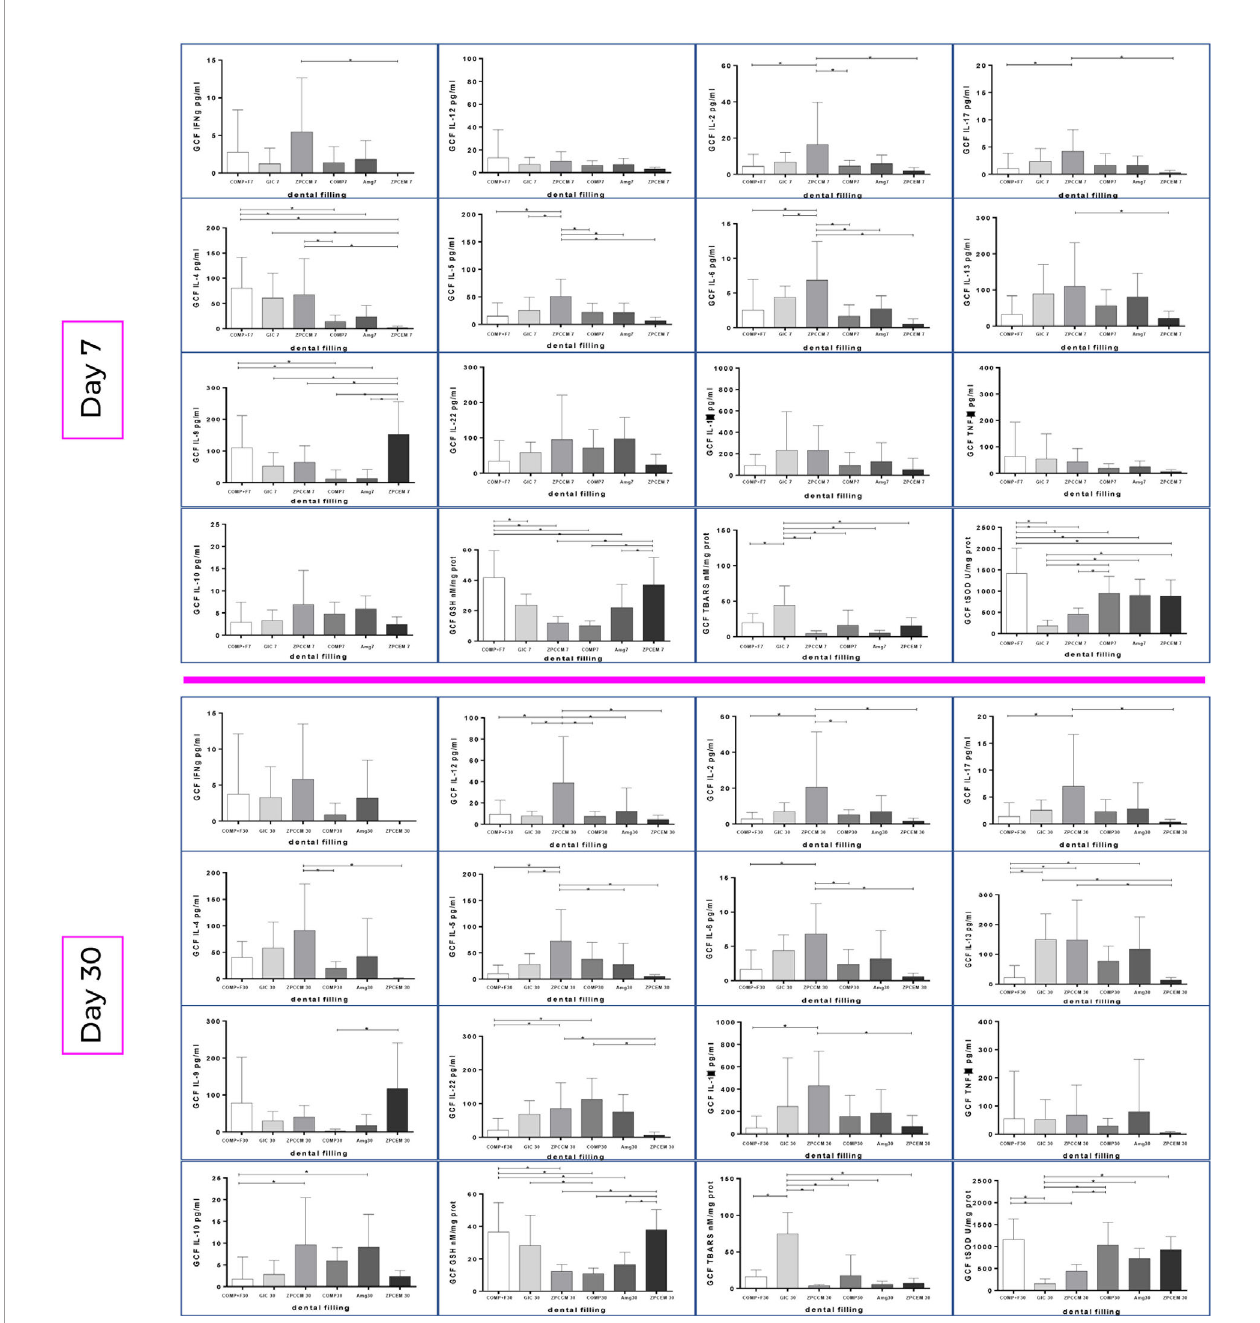
FIGURE 2 | Biomarker changes from baseline to 7 and 30 days post treatments by the experimental groups. ZPCEM showed signi fi cant changes at the 30D; thus, the levels of IL-17 signi fi cantly declined (p = 0.037), while reduced form of glutathione (GSH) and superoxide dismutase (SOD) increased compared to baseline (p < 0.05). In GIC, the GSH signi fi cantly increased from baseline to 7D (p = 0.036) and 30D (p = 0.021). In ZPCCEM, the levels of Th1 and Th2 markers as well as SOD signi fi cantly increased D7, while D30 in addition to Th1 and Th2 markers the IL-17 signi fi cantly increased relative to baseline (p < 0.05). In GIC group, GSH was single marker that signi fi cantly increased D7 (p = 0.045) and D30 (p = 0.015) compared to baseline. In AMG, the levels of IL-12 (p-0.30) and IL-22 (p = 0.027) signi fi cantly declined D30, while GSH (p = 0.040) and SOD (p = 0.030) levels signi fi cantly increased D7 and D30. In COMP, the levels of IL-13 (p = 0.045) and IL-22 (p = 0.021) signi fi cantly decreased D7, D30 IL-5 declined when compared to baseline (p = 0.027), while IL-17 and SOD signi fi cantly decreased at D7 and D30 (p < 0.05). In COMP+F, the levels of IL-17 declined (p = 0.045), while TNF a , GSH, and SOD signi fi cantly increased D7 (p < 0.05), and D30 IL-17, GSH and SOD preserved the trend from D7 (p < 0.05), while IL-5 declined compared to baseline (p = 0.040). ZPCEM, zinc phosphate cement; GIC, glass ionomer cement; ZPCCM, zinc-polycarboxylate cement; AMG, amalgam; COMP-resin, COMP+F- fl uoride loaded resin; *p <